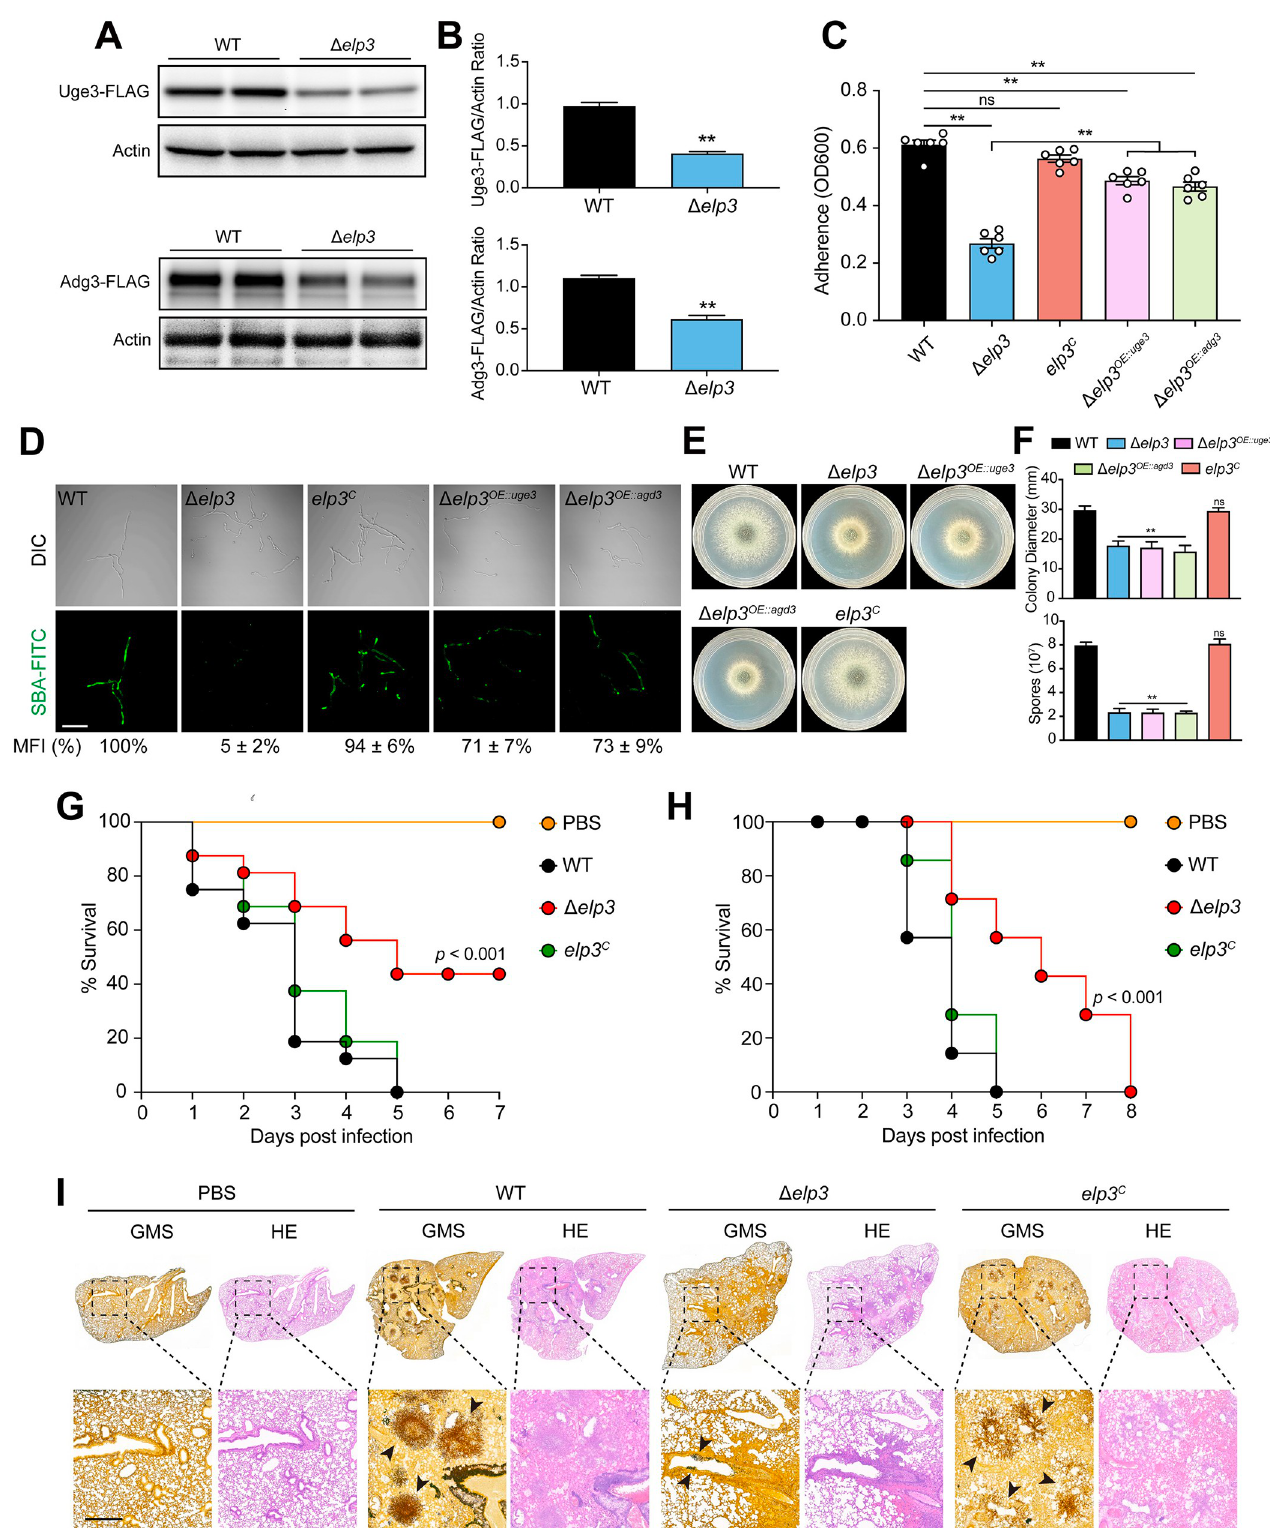
Fig 4. The elp3 null mutant exhibits reduced GAG production, adhesion and attenuated virulence. (A) Western blots show the protein expression of Uge3 and Agd3 in the wild-type and Δ elp3 strains. β -actin served as a loading control. (B) Quantified western blot signal intensity for Uge3-FLAG and